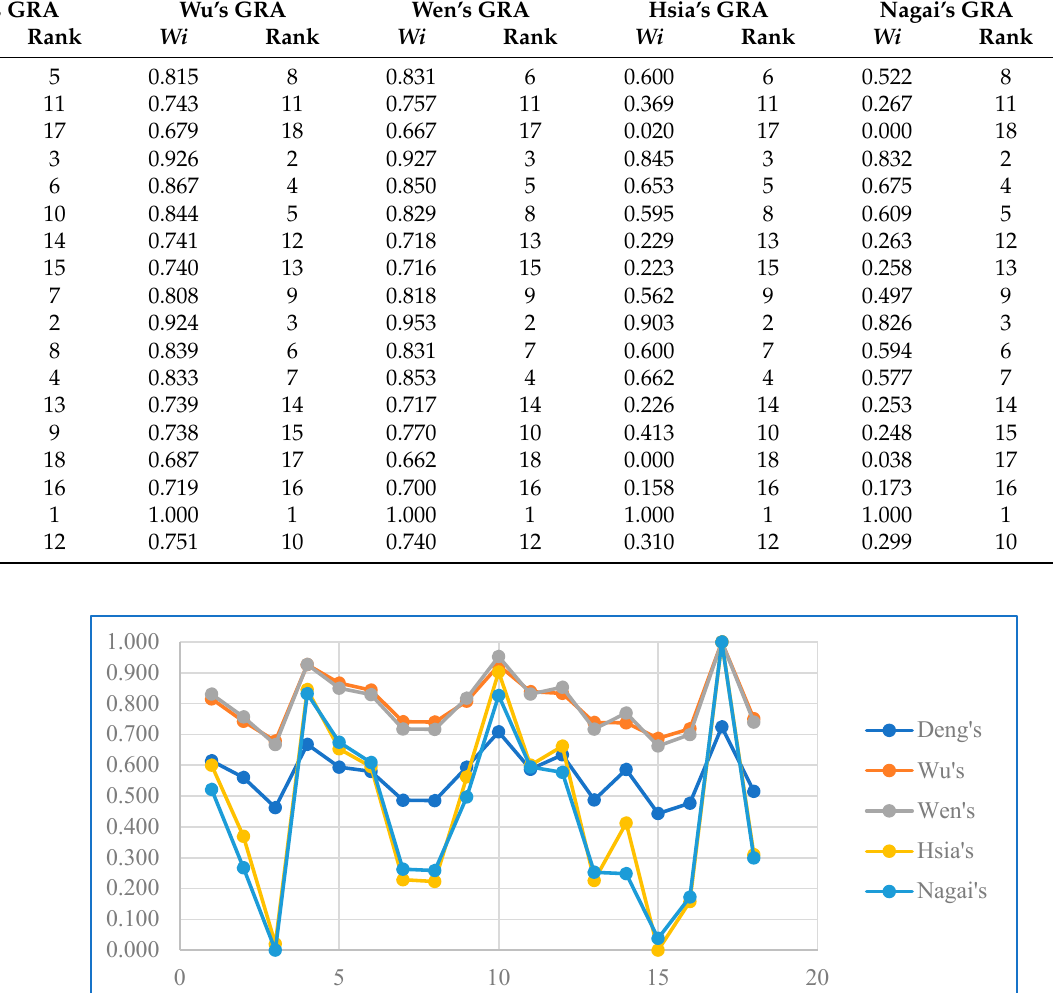
Figure 1. Failure mode ranking obtained using five GRA methods.